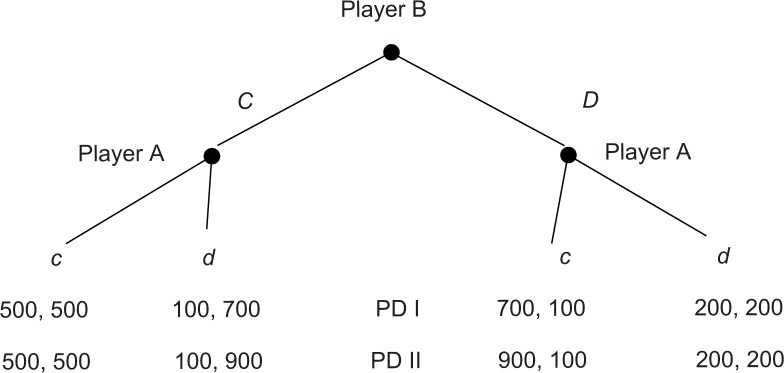
Payoffs in the two prisoner’s dilemma games [πB, πA].